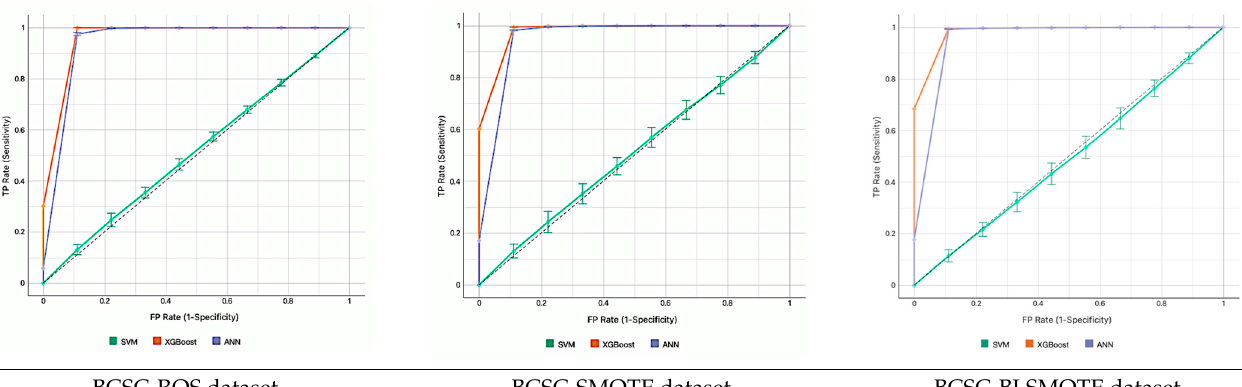
Table 12. ROC analysis of all the models based on the datasets balanced using oversampling techniques.